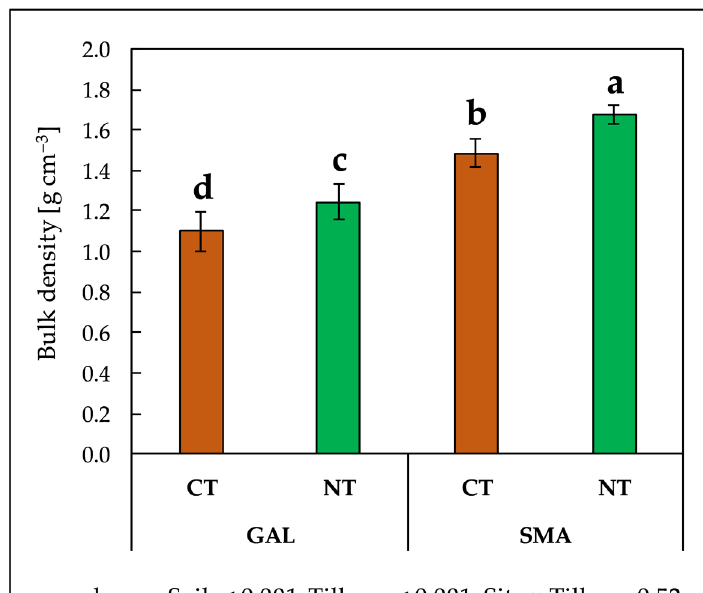
Figure 3. Effect of soil (GAL, on the left, and SMA, on the right), tillage system (CT, in brown, and NT, in green), and their interaction on soil bulk density (BD) at harvest. Reported values are means ( n = 4) ± SE (bars). Different letters indicate significant differences (Tukey’s HSD test at p < 0.05) between treatments.